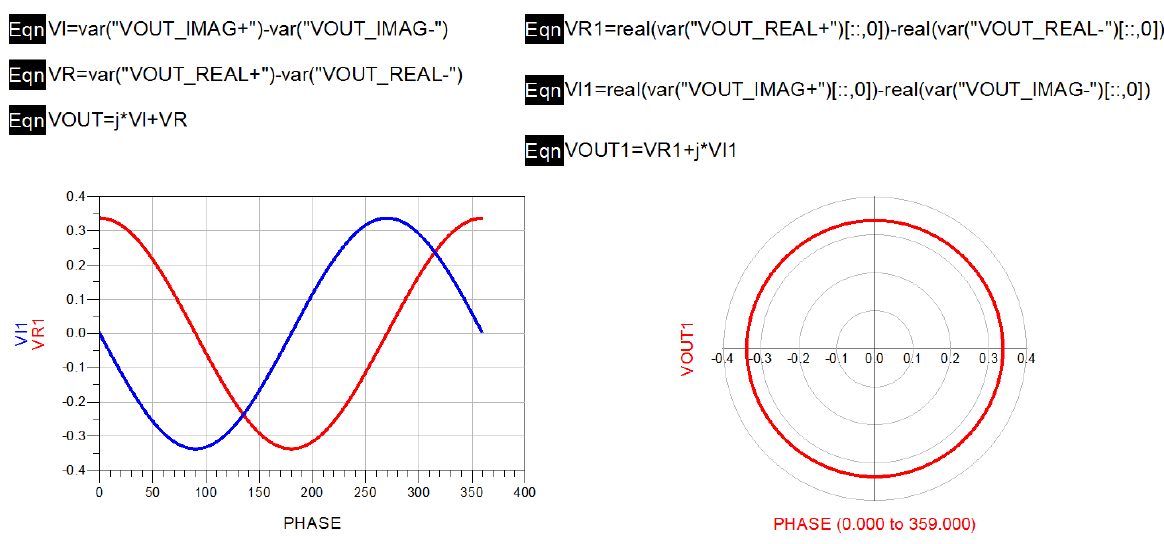
Figure 17. Phase scanning results of novel interferometric analog complex correlator.